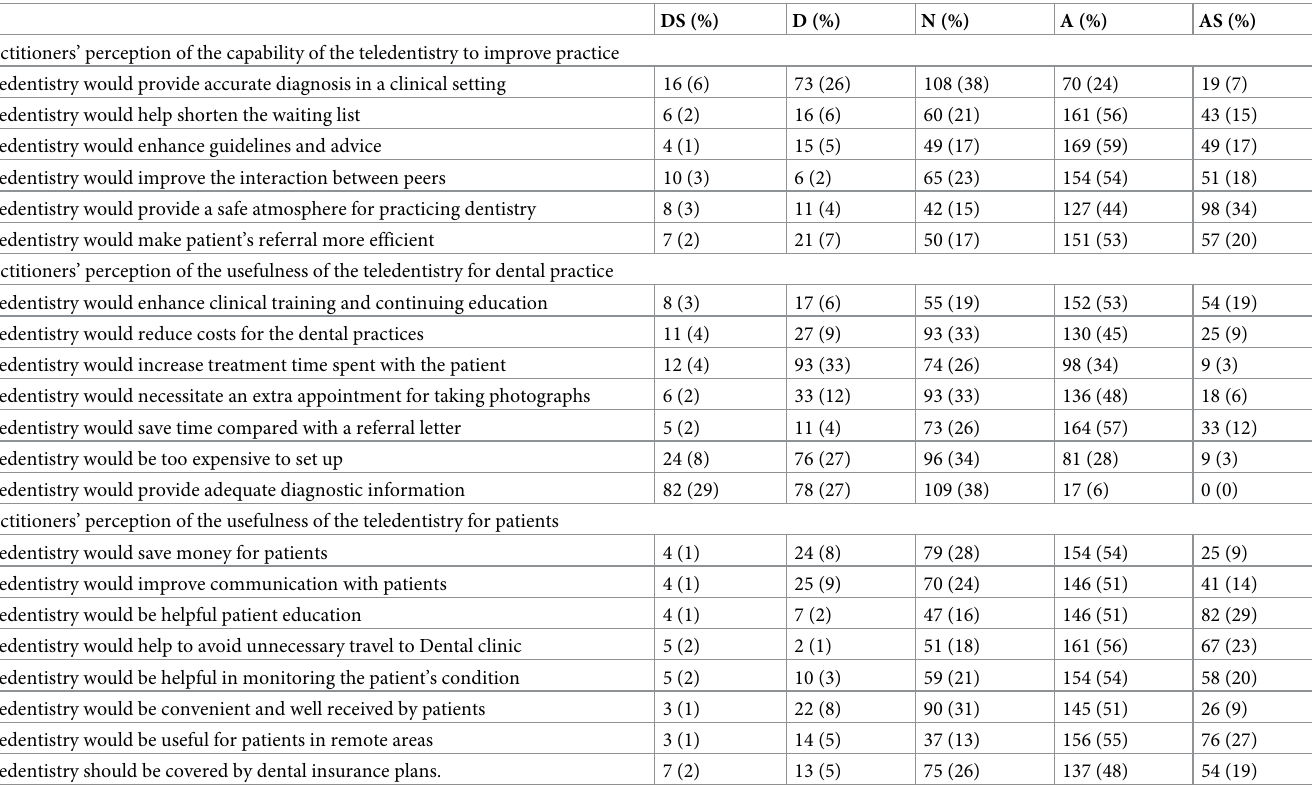
Table 3. Practitioners’ perceptions of teledentistry’s benefits in improving dental practice and patient care.